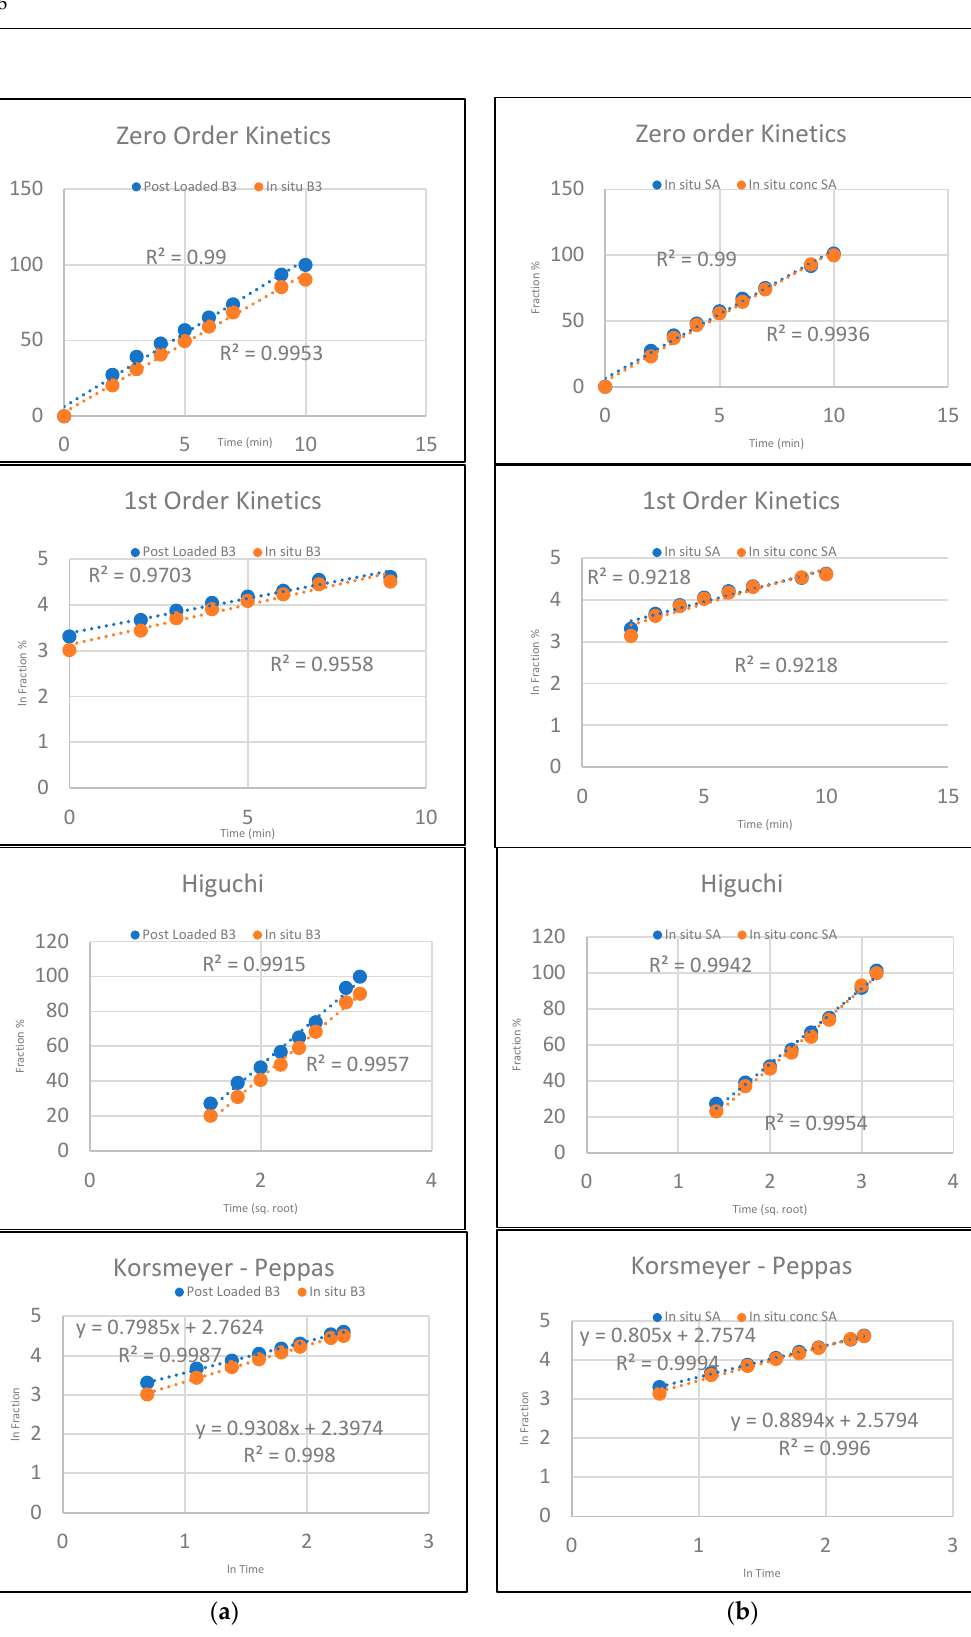
Figure 2. ( a ) Drug release kinetics profile-B 3 (Post-loaded and in situ); ( b ) Drug release kinetics profile-SA (in situ and in situ conc.). Table 5. Active release kinetics illustrate the (R 2 ), release rate constants ( K ) and release exponent ( n ) value for the formulations.